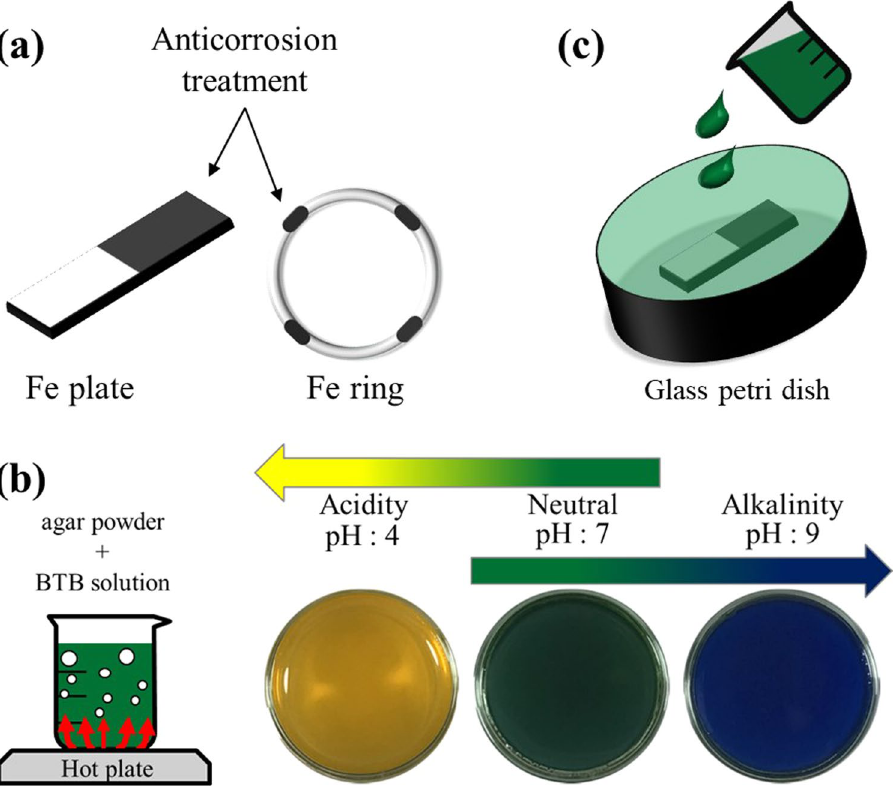
Figure 7. Visualization of the ion concentration distribution with ( a ) Fe samples coated with oil-based paint as an anticorrosion treatment. ( b ) Preparation of BTB agar gel and its coloration: green (neutral), yellow (acidic), and blue (alkaline). ( c ) Observation of BTB agar gel containing Fe